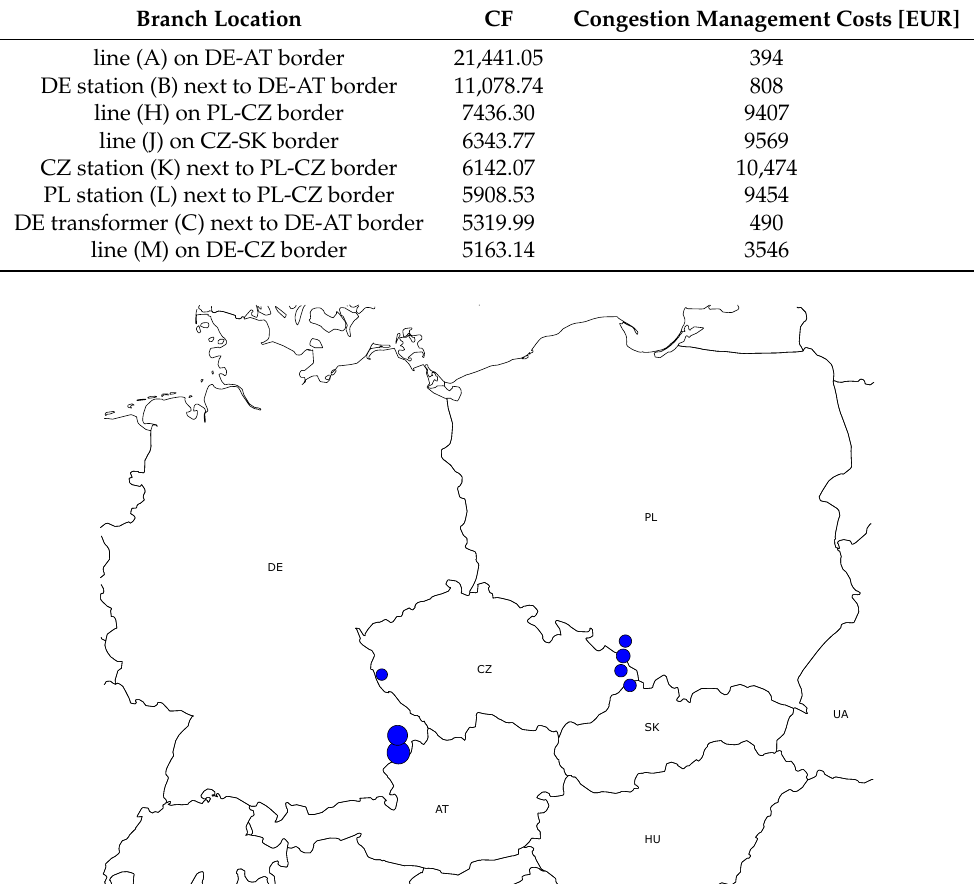
Figure 3. Top 7 locations according to the top 8 CF values (cf. Table 4). The volume of the circle at location is proportional to the CF aggregated for branches in the same location. Source: own